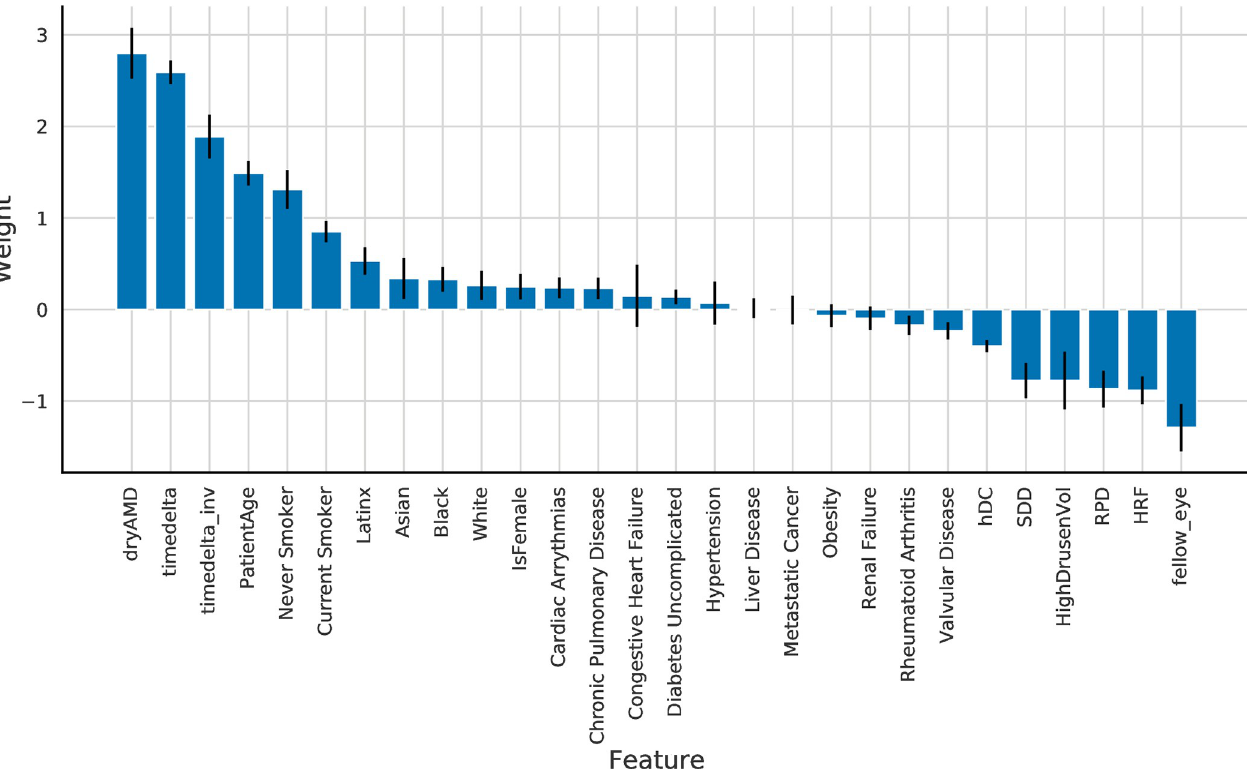
PLOS Digital Health | https://doi.org/10.1371/journal.pdig.0000106 February 15,